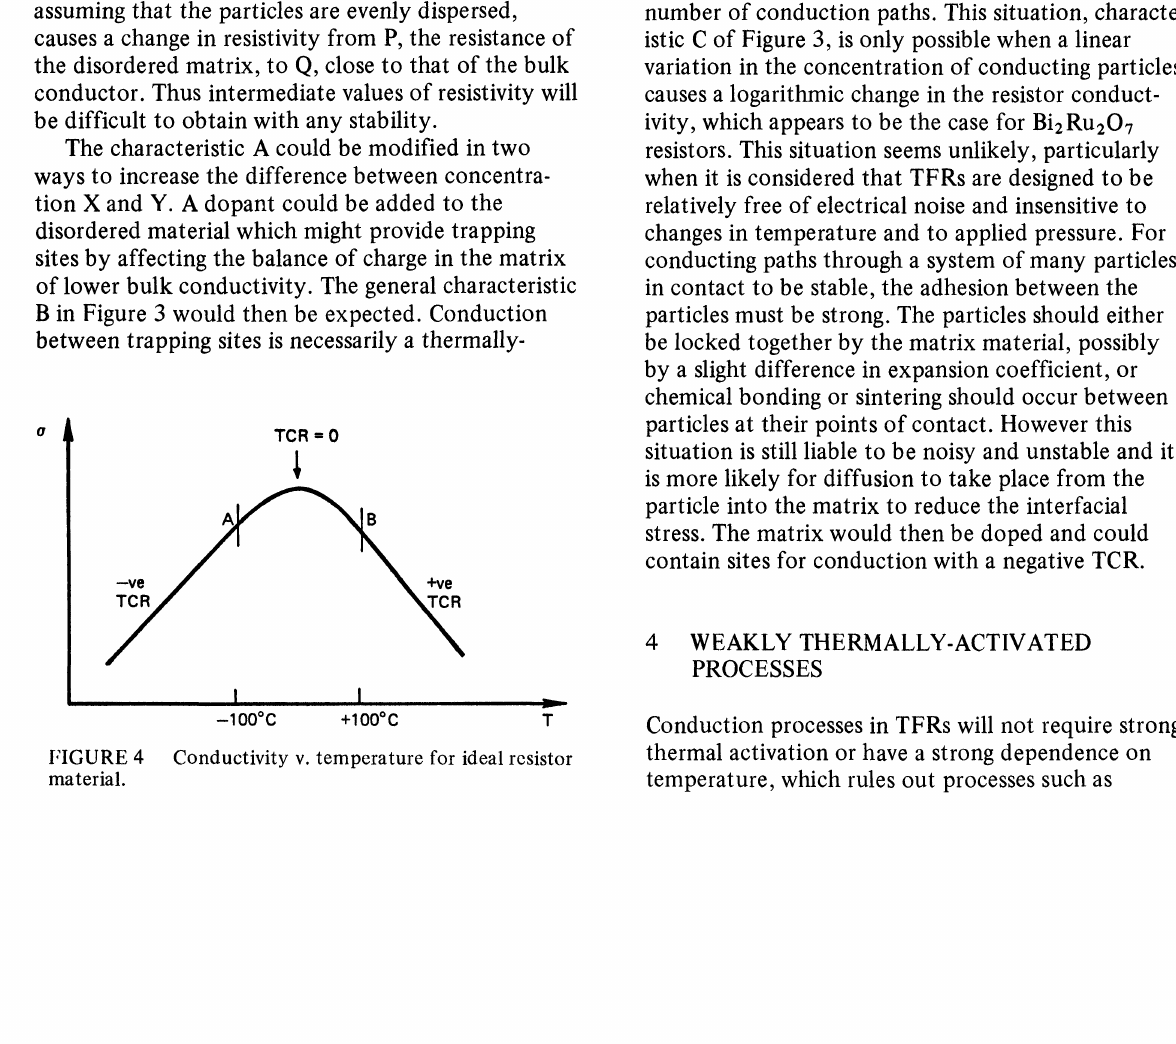
particles in plastic and Christen and Hewitt 2 for Au-SiO2 cermets.